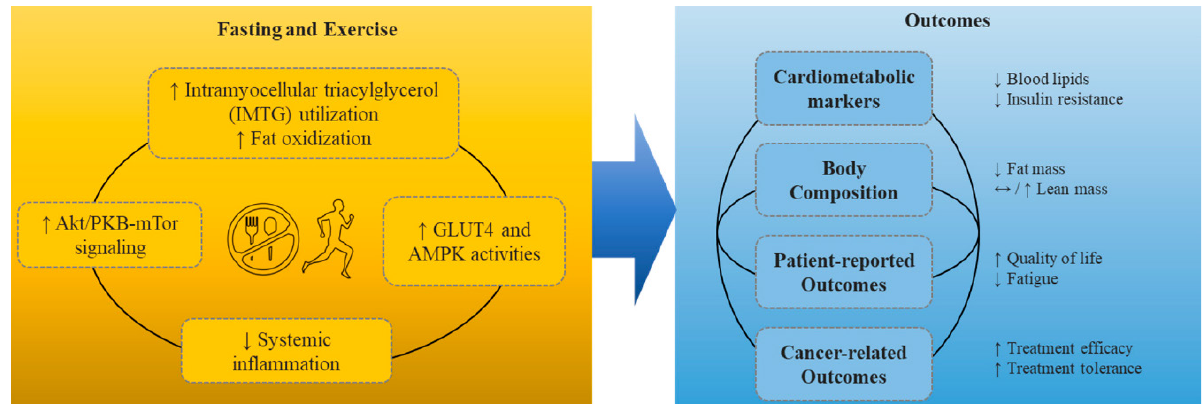
Figure 2. Some of the Mechanisms Related to the Effects of Fasting and Exercise on Cancer Patients